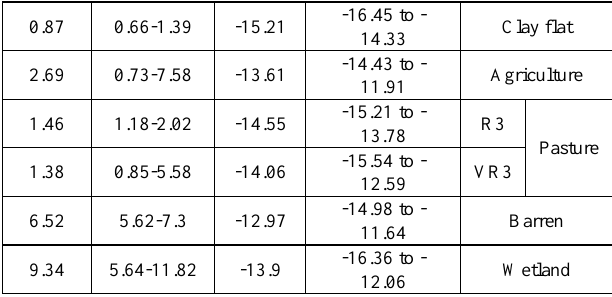
Table 2. Backscattering coefficient and estimated surface roughness in VV polarization